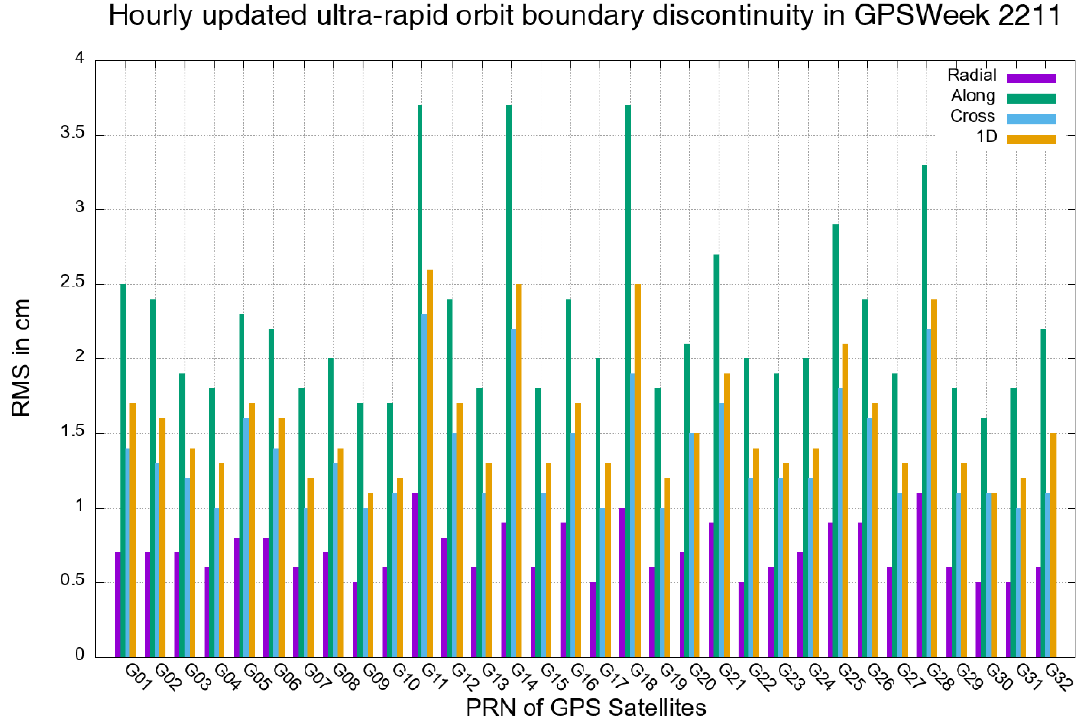
Figure 15. Mean RMS of overlapping in the RAC components and 1-D of GPS satellites.